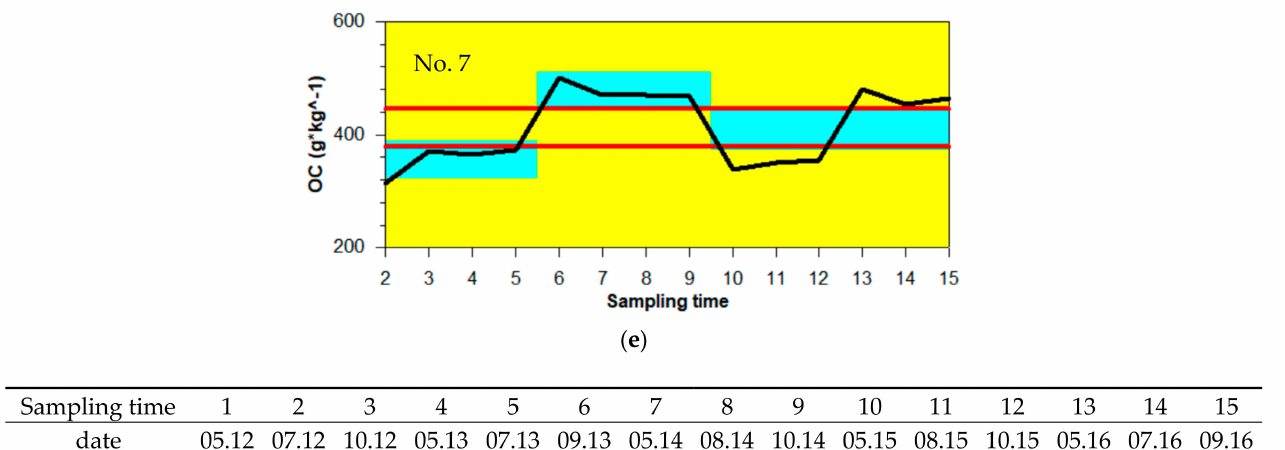
Figure 9. Change—point analysis for OC content in the O horizon on research plots: ( a ) No. 1, ( b ) No. 4, ( c ) No. 5, ( d ) No. 6, ( e ) No. 7.